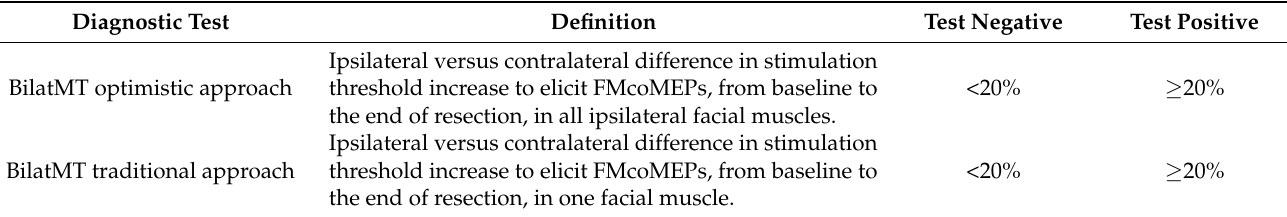
Table 1. Overview of warning criteria and outcome